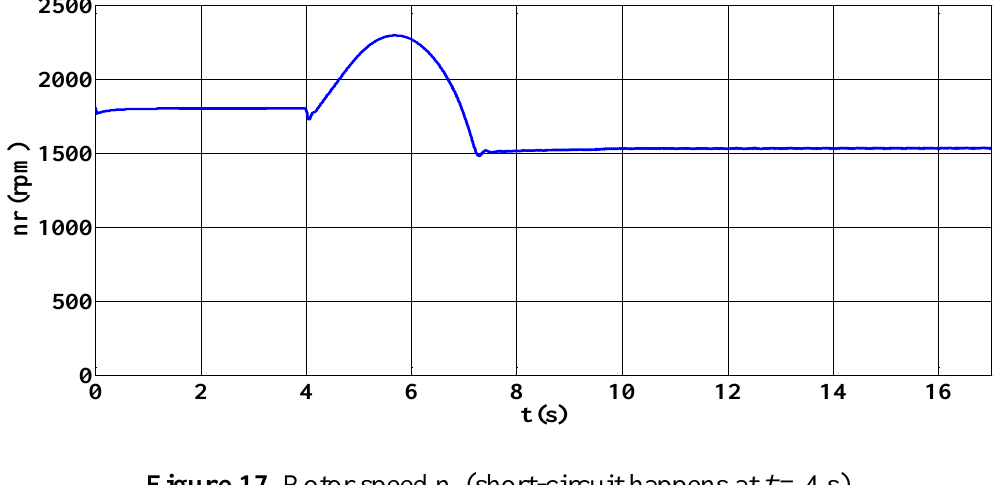
Figure 17. Rotor speed n r (short-circuit happens at t = 4 s).